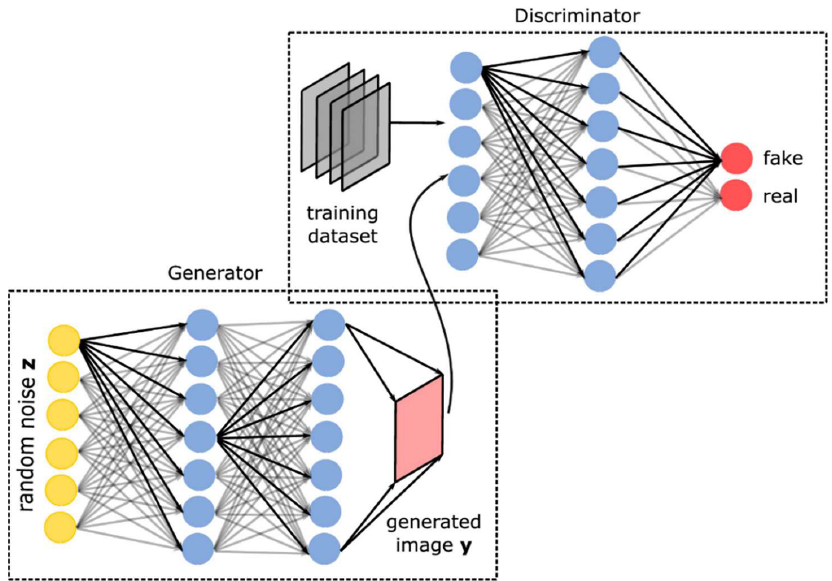
Figure 6. The typical architecture of a GAN (source: [9]). There are two parts: a generator G and a discriminator D. After enough training epochs of this minimax two-player game, G can generate high quality fake images just from random noises, and D try to distinguish real and fake images.